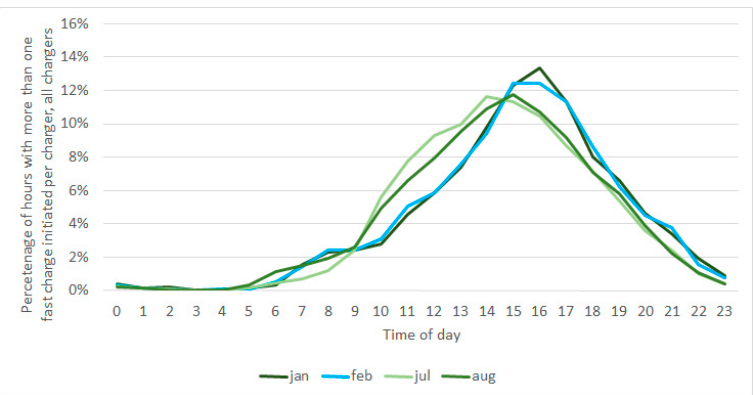
Figure 18. Share of hours with more than one fast charge initiated by time of day, January, February, July, August. Average of all chargers. Source: Dataset 1 and own analysis.